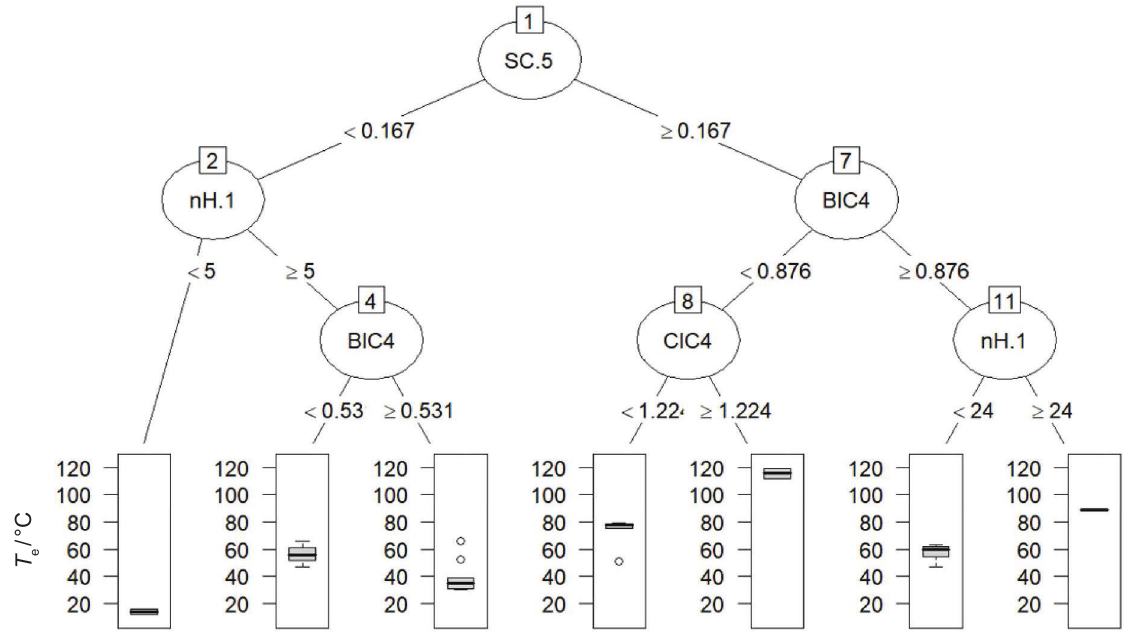
Fig. 2 – Decision tree model for the prediction of eutectic temperatures, T